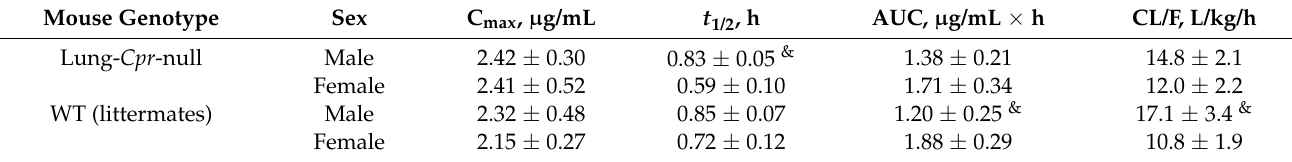
Figure 2. Levels of PQ in plasma following intraperitoneal injection. Three- to four-month-old lung- Cpr -null males and females and their age- and sex-matched WT control littermates received a single intraperitoneal dose of PQ at 20 mg/kg. ( A ) Representative chromatograms of PQ in plasma: ( green ) a blank sample; ( blue ) a blank mouse plasma sample supplemented with PQ standard (1 µ g/mL); and ( red ) a mouse plasma sample obtained at 15 min after a single intraperitoneal injection of 20 mg/kg PQ). The signal was monitored at 257 nm, the retention time for PQ was ~4.7 min. ( B ) Calibration curve for PQ determination, constructed using PQ standard solutions in blank plasma. ( C , D ) Levels of PQ in plasma of males ( C ) and females ( D ) were determined from individual mice as described in Material and Methods . Data represent means ± S.D. ( n = 3–4). A significant genotype- and sex-related difference was not found ( p > 0.05) at any examined time point. Table 1. Pharmacokinetic parameters for PQ in plasma of lung- Cpr -null mice and their control littermates. Plasma levels of PQ from Figure 2C,D were used to calculate the pharmacokinetic parameters, including C max (maximal concentration), t 1/2 (half-life), AUC (area under concentration-time curve), and CL/F (clearance). Values shown are means ± S.D. ( n = 4 for males and n = 3 for females). & , p < 0.05, compared to corresponding female value (one-way ANOVA followed by Bonferroni multiple comparisons test).